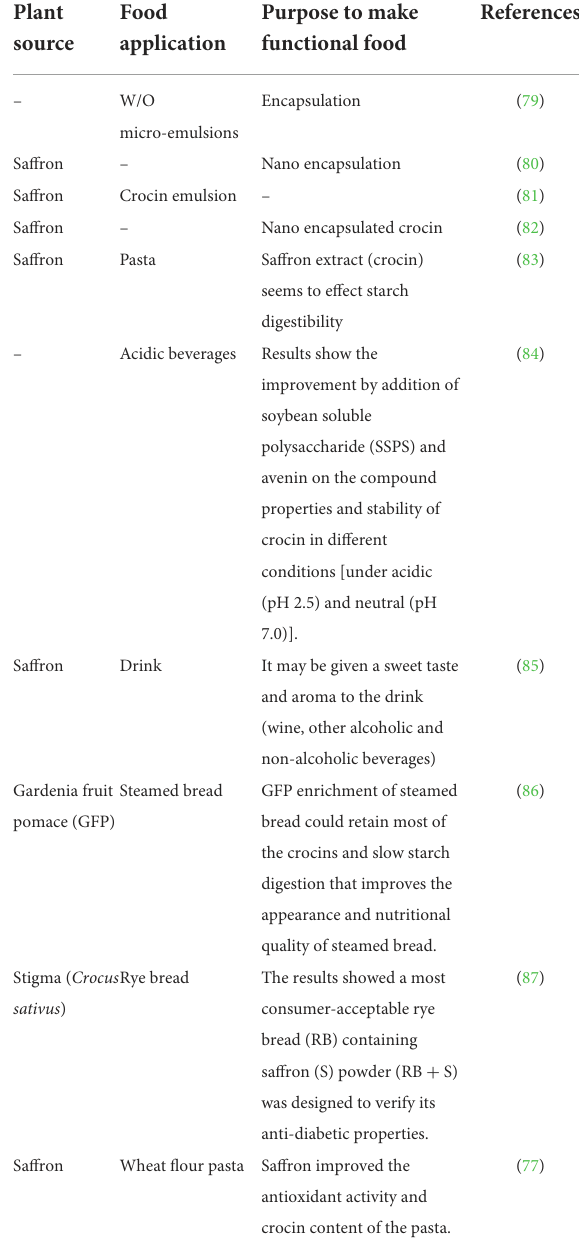
TABLE 2 Food applications of